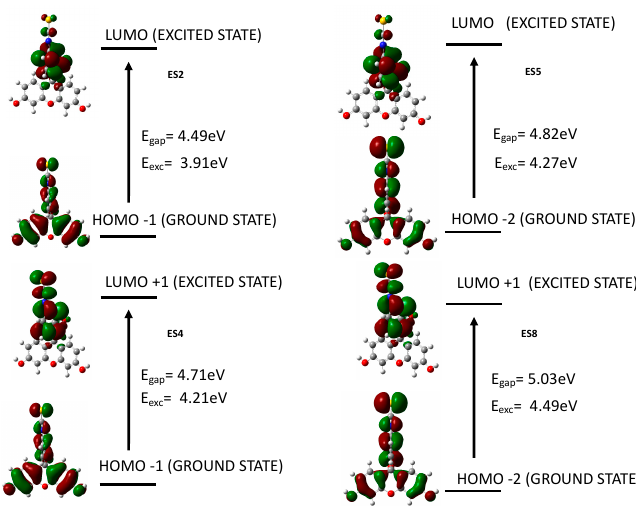
Figure 13. The four most important calculated energy transitions between the molecular orbitals of fluorescein in water. The main electronic configurations of each transition are shown.